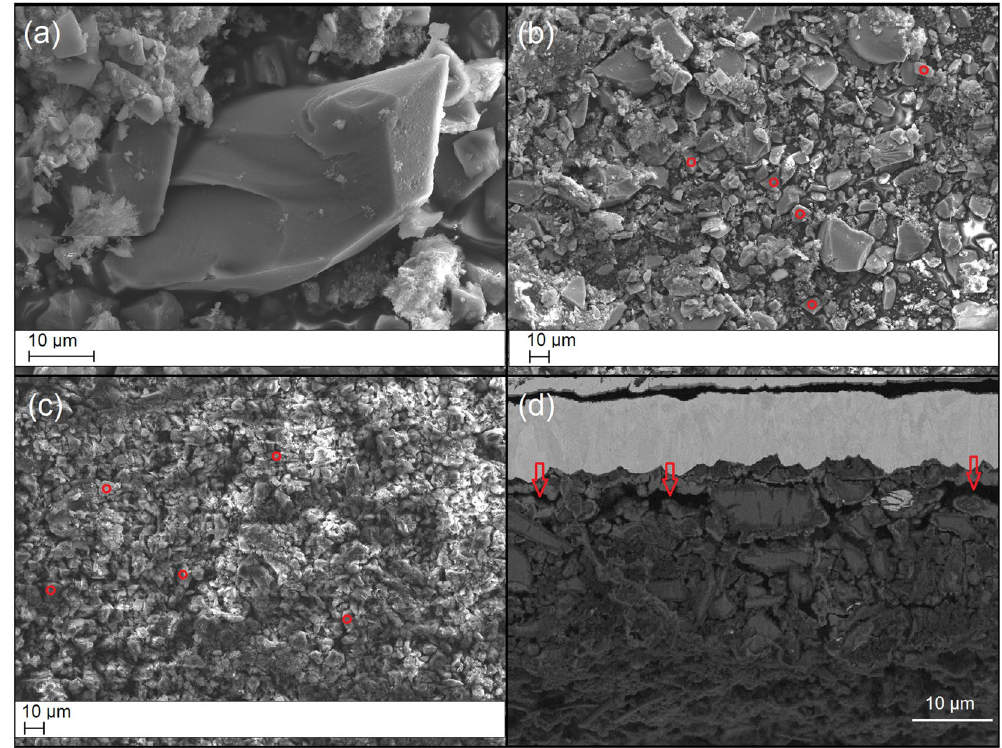
Figure 3. SEM images of non-cycled and cycled particles/electrode. SEM images of non-cycled particles ( a – b ) and particles cycled for 42 cycles ( c ). After cycling, the edges of the particles become uneven and somewhat blurry. A few 10 µ m sized particles are indicated by red circles. Other objects in the images are from CB or from binder materials (CMC and PAA). ( d ) Side view from an ion cut electrode from TCPSi 38 sample after 300 cycles. The top part is the copper current collector. Empty spaces between the current collector and active material are indicated by red arrows.